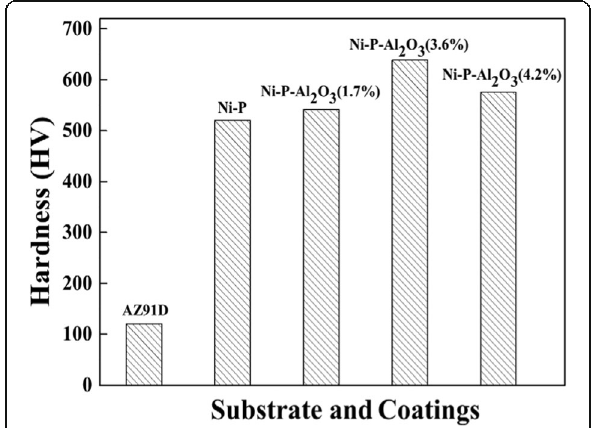
Fig. 5 Hardness of the AZ91D substrate, the Ni-P coating, and the Ni-P-Al